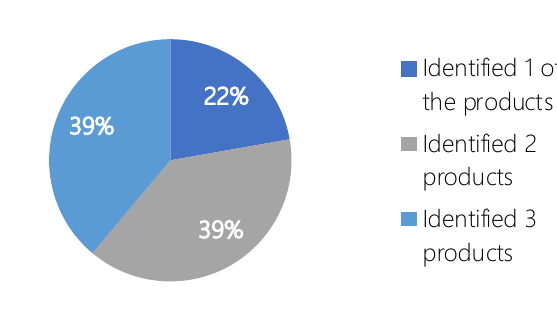
Figure 23. Value Classification Results.